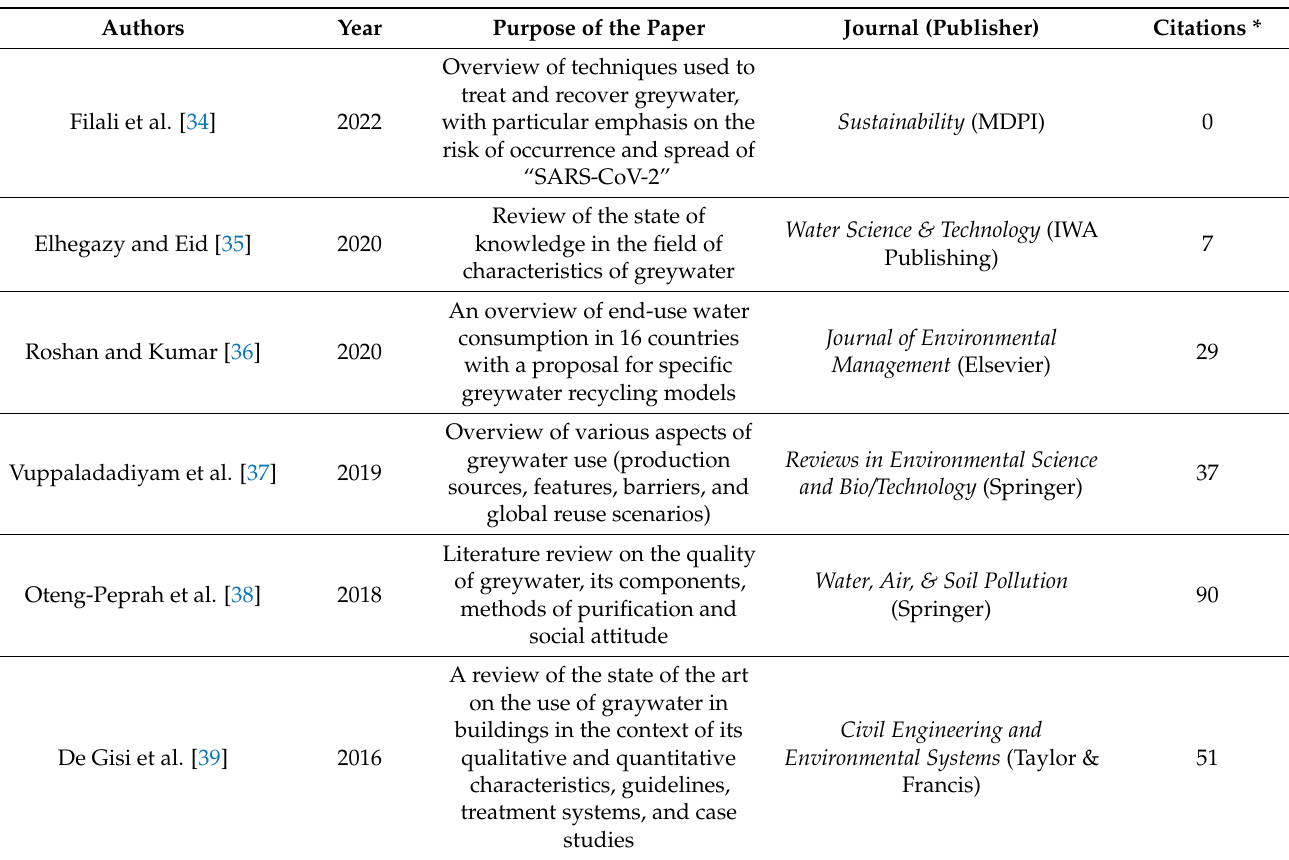
Table 2. Review papers in greywater recycling